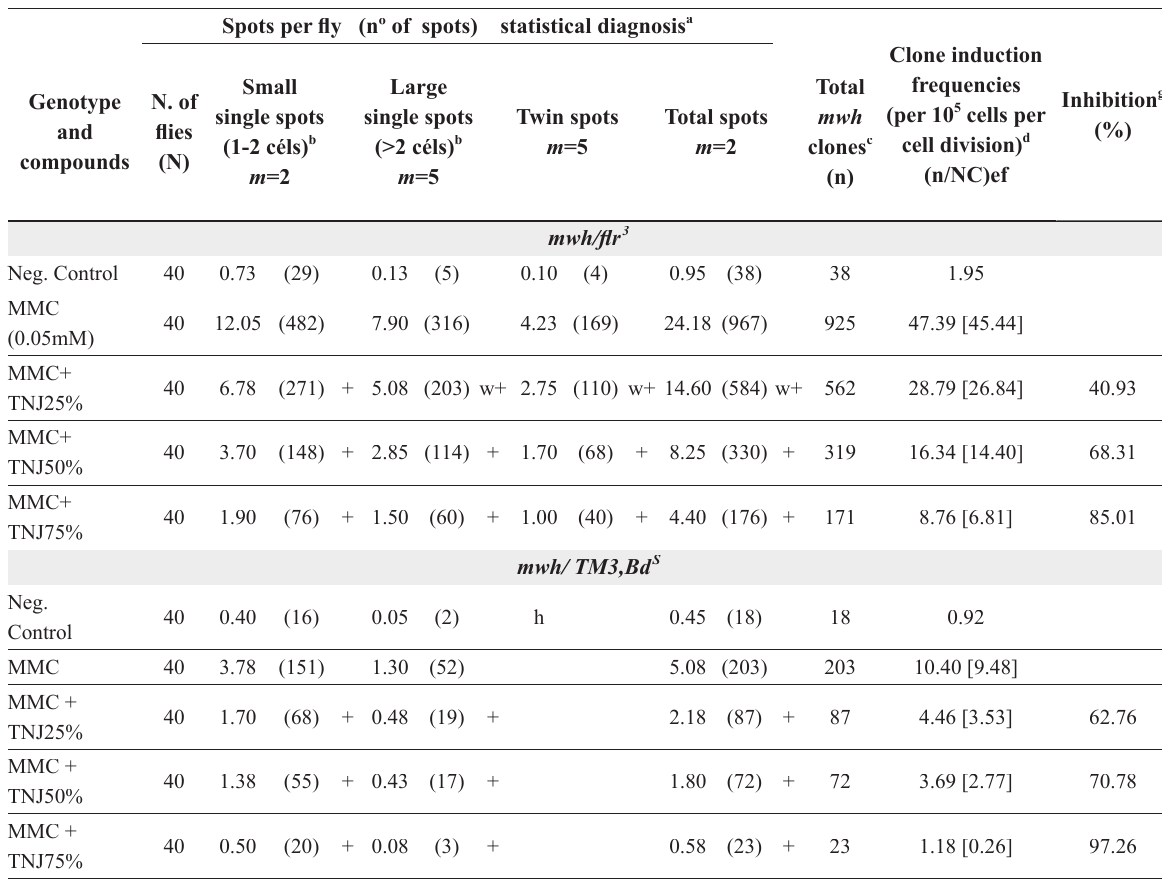
Effect of the co-treatment (TNJ + MMC and TNJ + DXR) in somatic cells of Drosophila melanogaster using the wing SMART standard cross. Drosophila melanogaster using the wing SMART standard cross. Drosophila